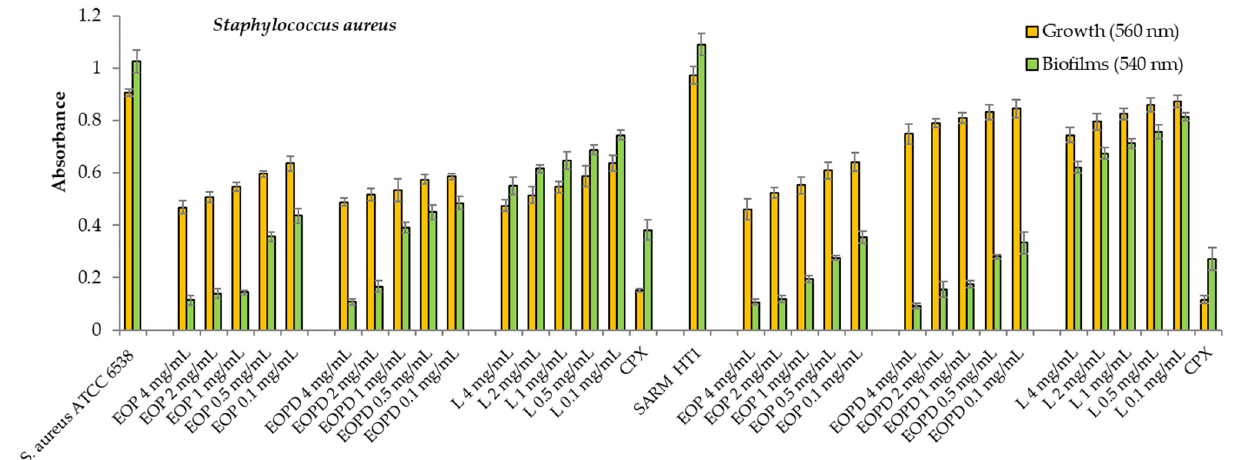
Figure 4. Growth and biofilms of Staphylococcus aureus (ATCC 6538 and methicillin-resistant